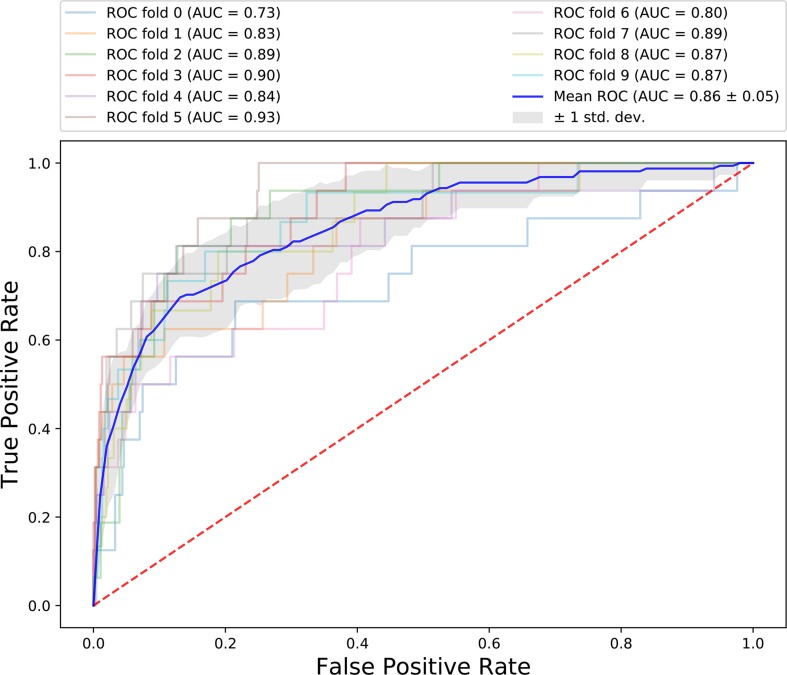
ROC for 10-fold cross-validation.